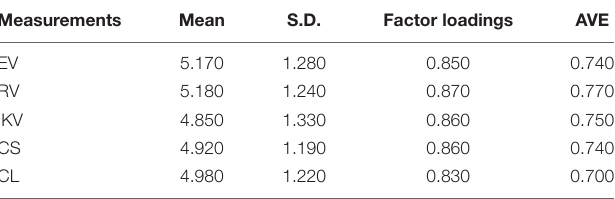
TABLE 6 | Factor loading.